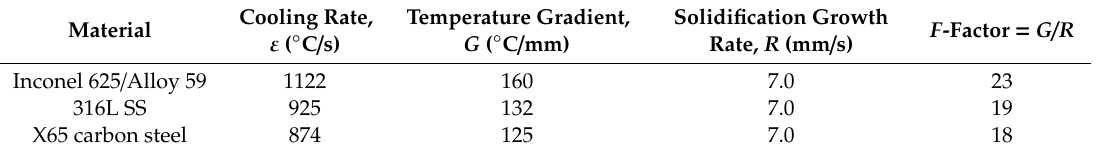
Table 3. Estimated solidification parameters at the WM centerline on top-plane. Cooling rate is calculated for temperature range from peak temperature to solidus point.